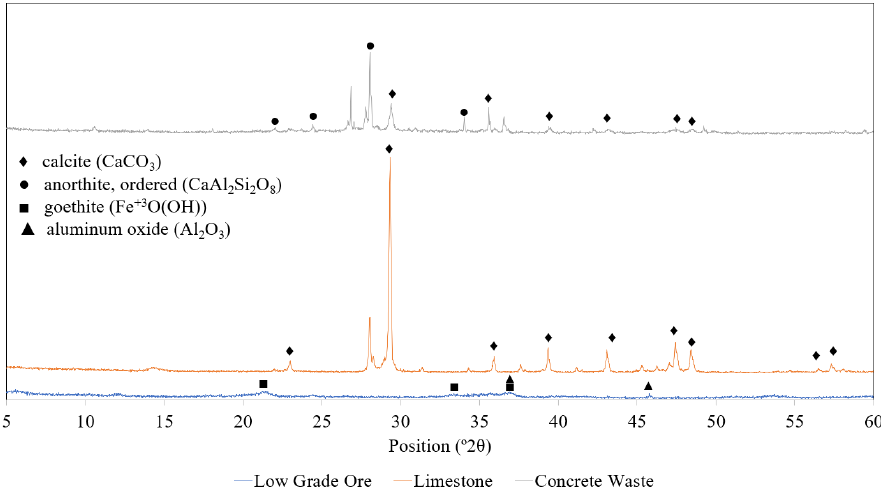
Figure 2. XRD patterns of concrete waste, limestone, and LMW.